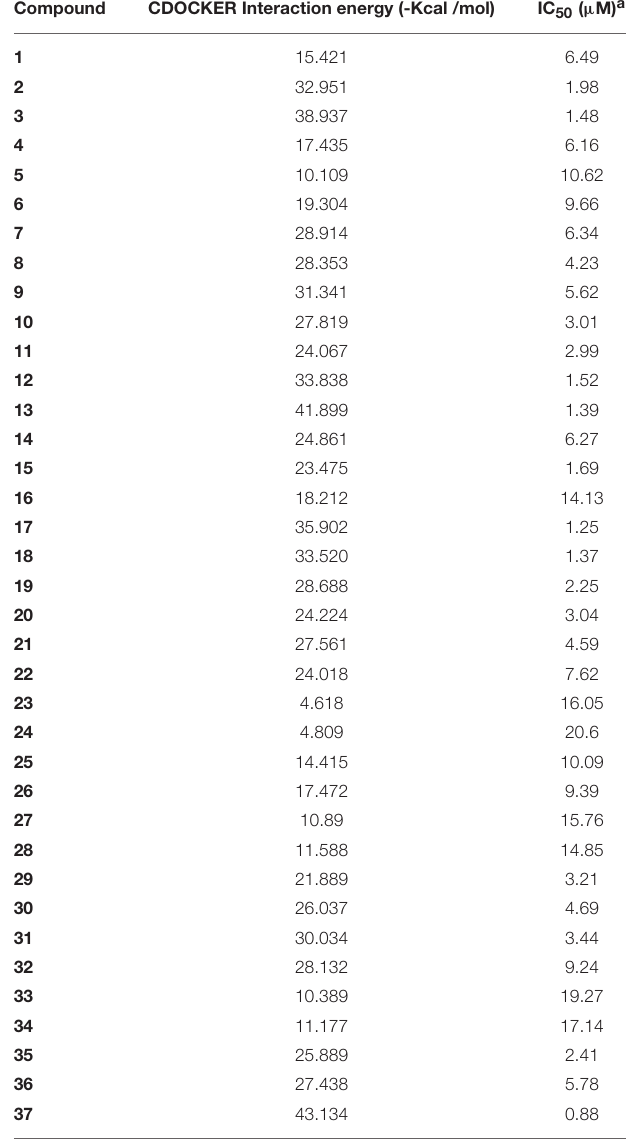
TABLE 1 | CDOCKER interaction energies of most favorable pose and IC 50 values of